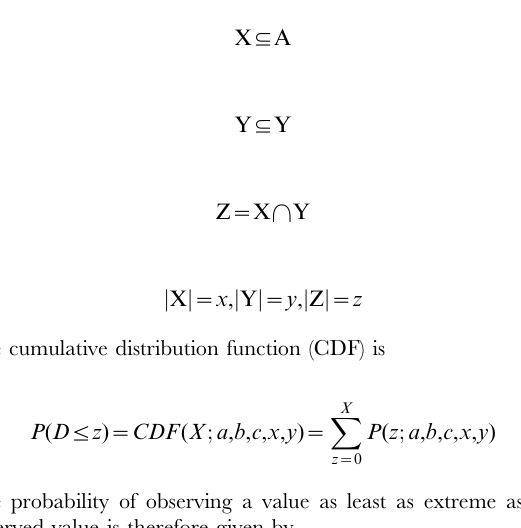
green). Figure S3 Gene and phenotype networks at MP level 8. Attributes are as in Fig. 1 A–D. Figure S4 Topological analysis plots of level 8 networks, with cut-off. A)–B) Gene network degree distribution and clustering coefficient for the gene network at MP level 8, d cutoff = 0.011. C)– D) Phenotype Network degree distribution and the clustering coefficient distribution for the phenotype network at level 8, d cutoff = 0.002. Black lines indicate a line of best fit using linear regression. Figure S5 Topological analysis plots of level 5 gene networks, with no d cut-off. A–B) Gene network degree distribution and C) clustering coefficient distribution for the gene network at MP level 1, d cutoff = 0. D–F) The same quantities for MP level 5. G–I) The same quantities for MP level 8. Black lines indicate a line of best fit using linear regression. Figure S6 Topological analysis plots of phenotype networks with no cut-off. A–B) Gene network degree distribution and C) clustering coefficient distribution for the gene network at MP level 5, d cutoff = 0. D–F) The same quantities for MP level 8.